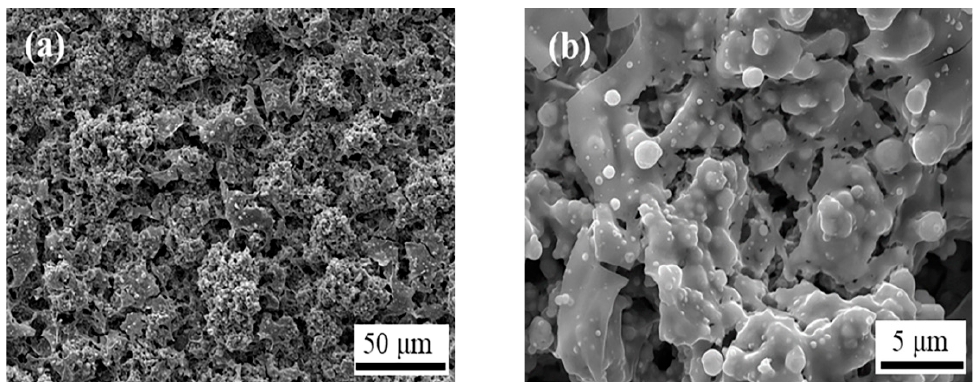
Figure 3. The surface morphology of YSZ/LSM prepared by ethanol SPPS at a spraying distance of 60 mm: ( a ) Low magnification. ( b ) High 60 mm: ( a ) Low magnification. ( b ) High magnification.